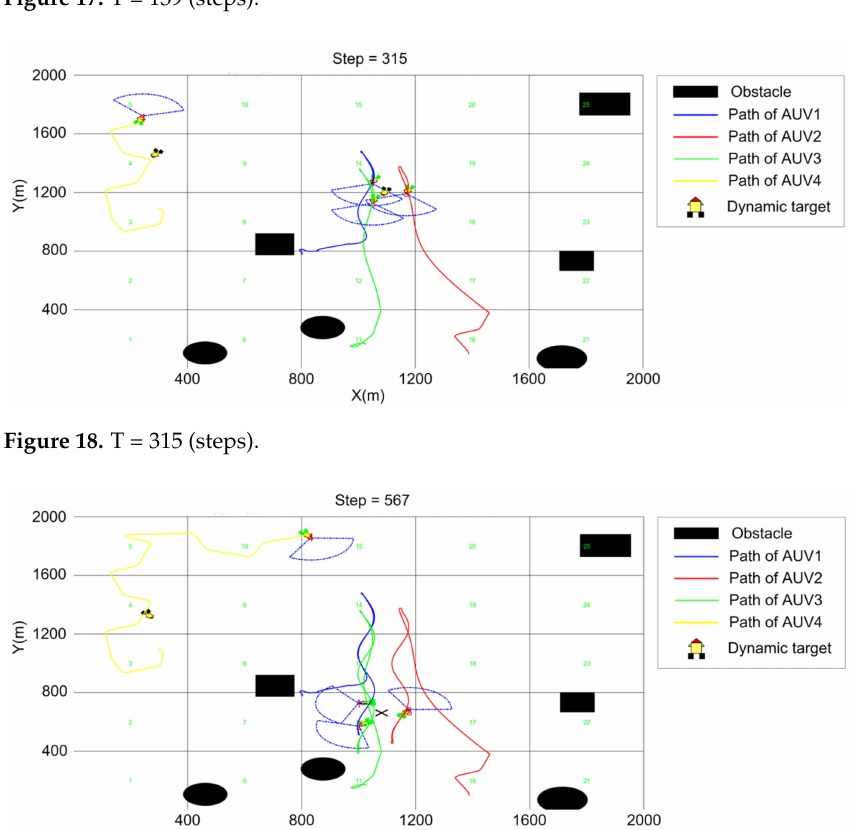
Figure 17. T = 139 (steps).